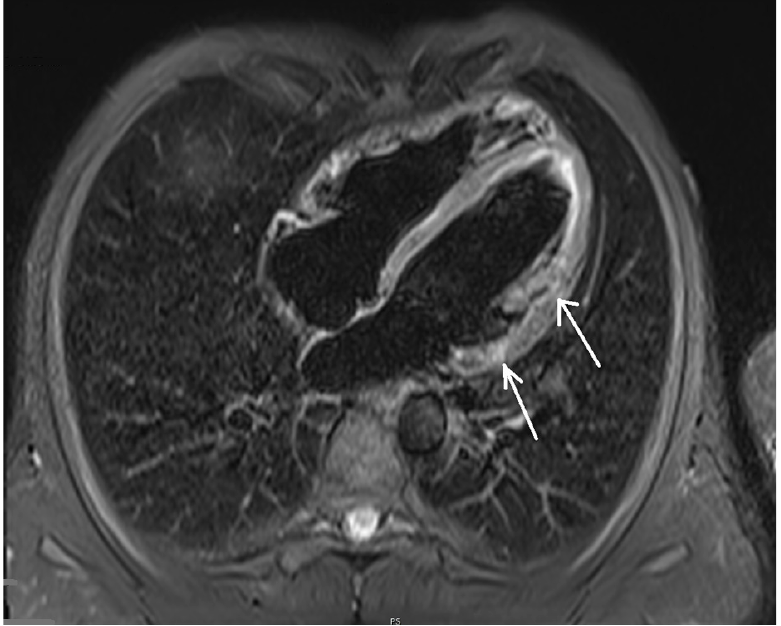
Figure 5. Magnetic resonance imaging of the heart showing disseminated subepicardial and midwall late enhancement lesions here in the lateral wall of the left ventricle (arrows).